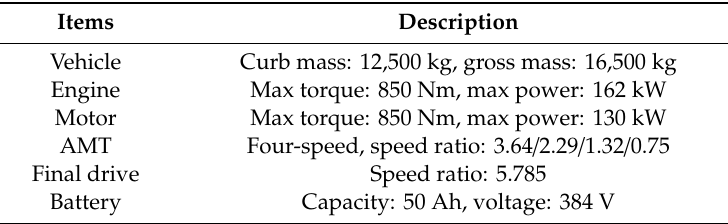
Figure 4. The configuration of the studied plug-in hybrid electric bus (PHEB). Table 1. Main parameters of the PHEB. Table 1. Main parameters of the PHEB.